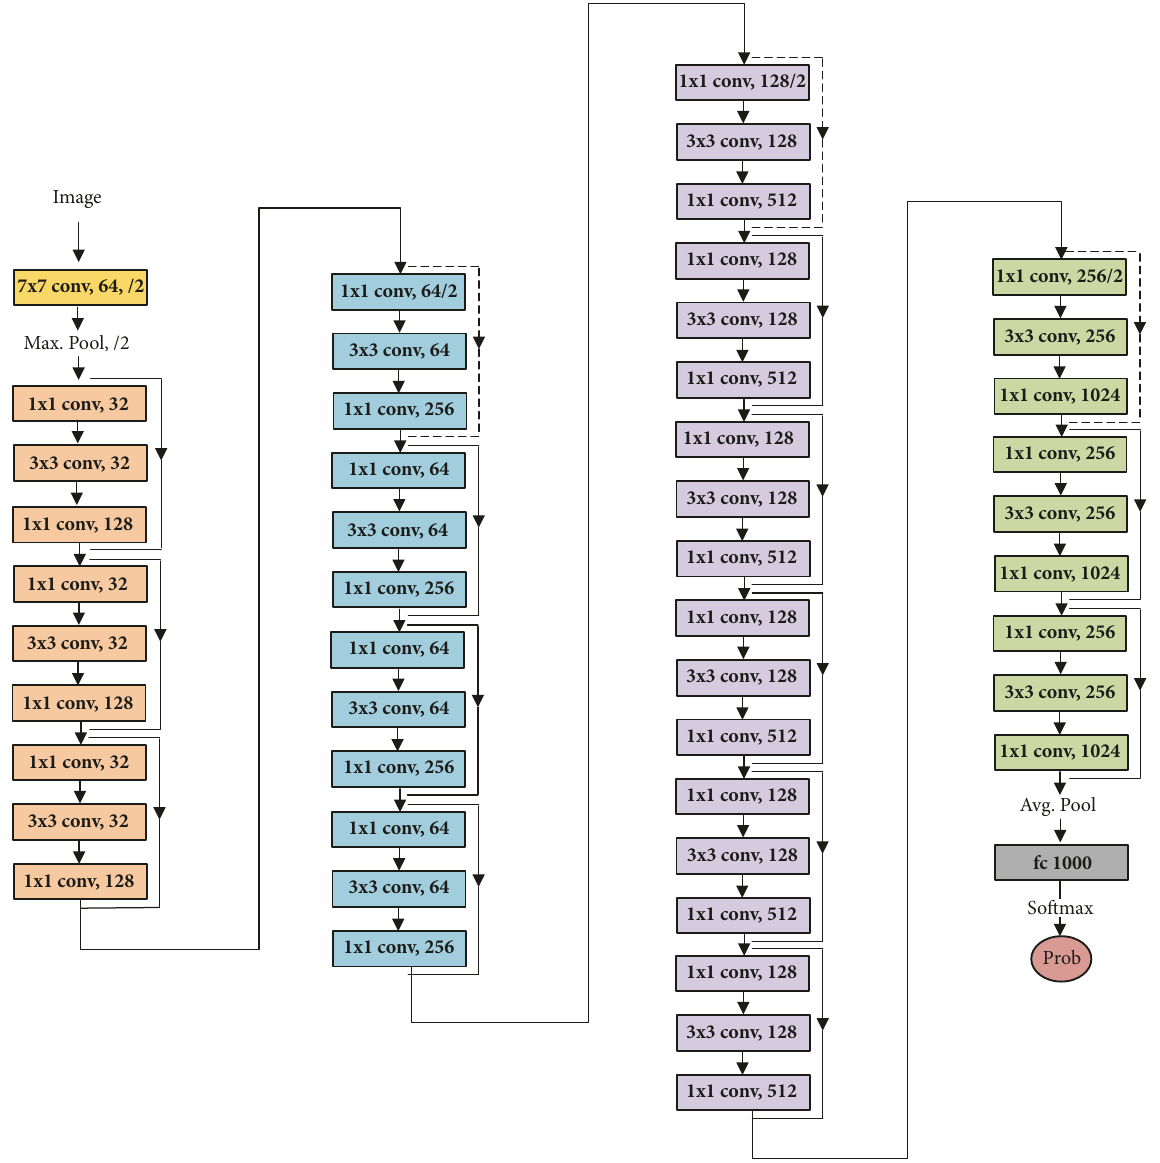
Figure 4: Block diagram of Resnet-50 1 by 2